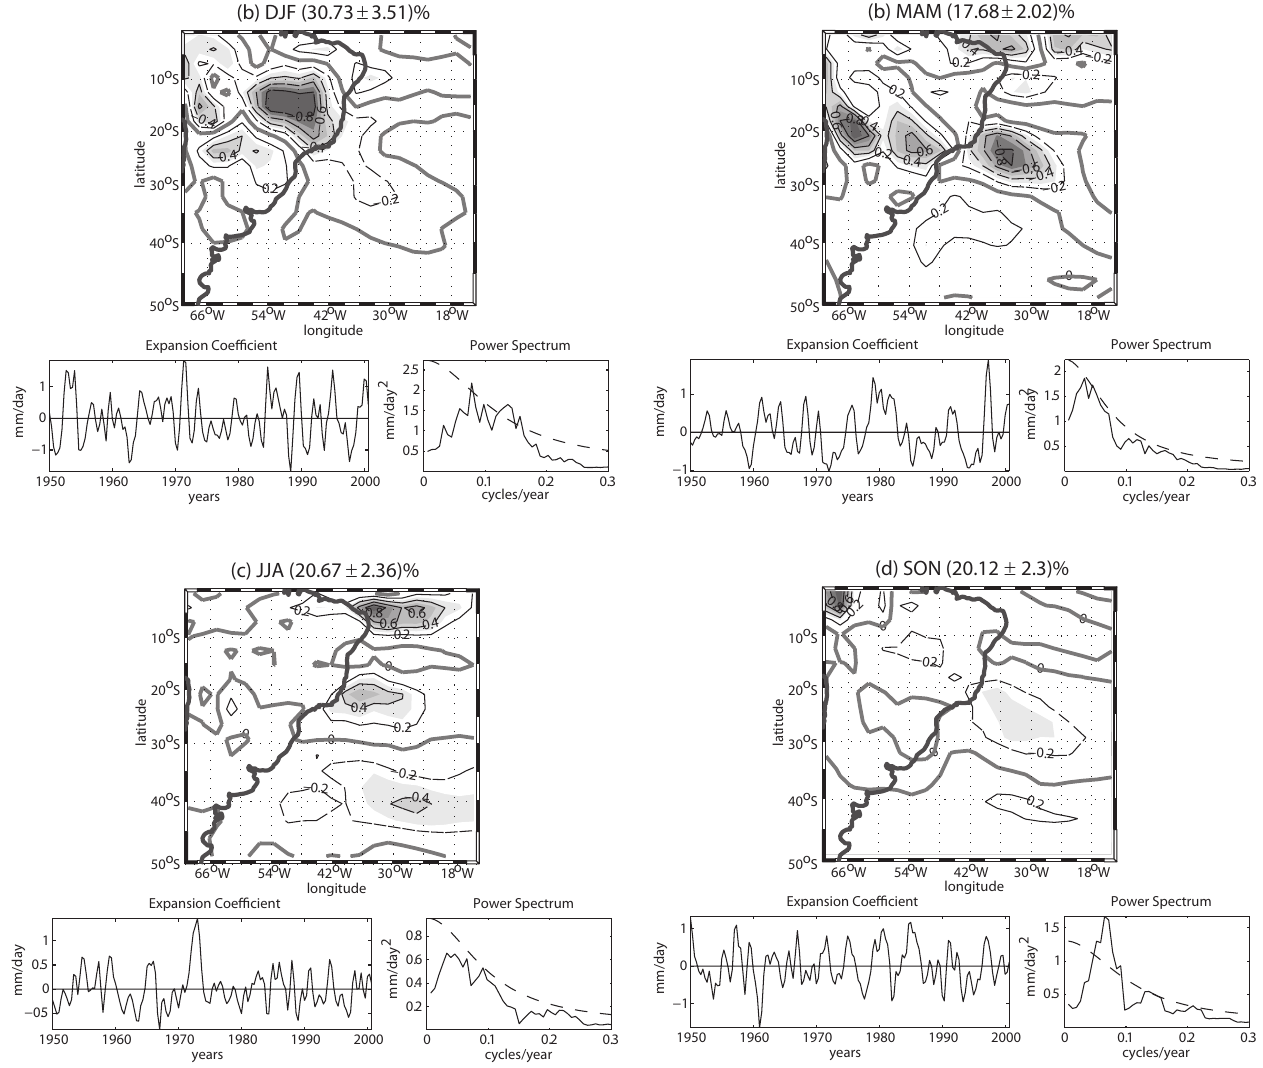
Fig. 5. First mode of REOF for simulated precipitation from EXP2. Shaded areas represent eigenvector magnitudes higher than | 0.3 | . Time series of expansion coefficients (mmday − 1 ) and the associated power spectrum are located in the panel below. The power spectrum is calculated via multitaper method. Frequencies above the dashed line are significant at the 95% level relative to a red noise background spectrum. (a) DJF, (b) MAM, (c) JJA and (d)